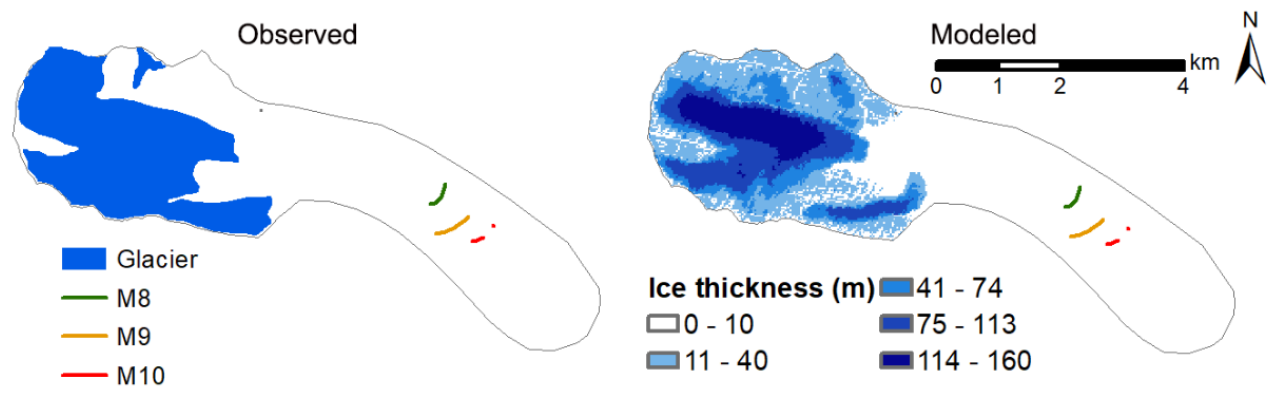
Figure 3. Comparison of observed modern and modelled glaciers under modern climatic conditions in the Gaerqiong Valley.